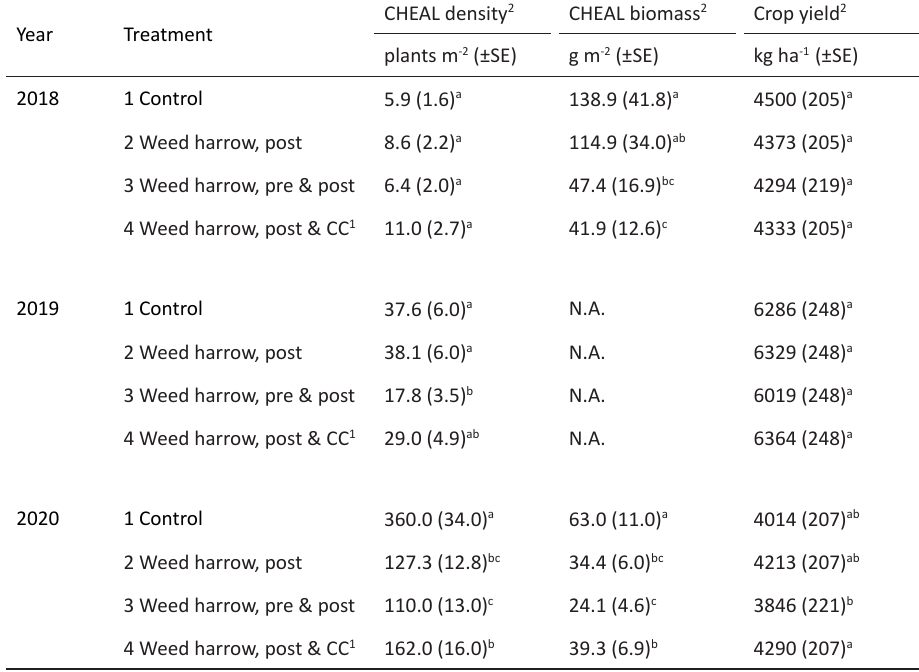
Table 4. Effect of weed harrowing treatments on late-summer abundance of C. album and crop yield (LSMeans with standard error). Assessments were made each year in August close to the harvest (see Table 2).